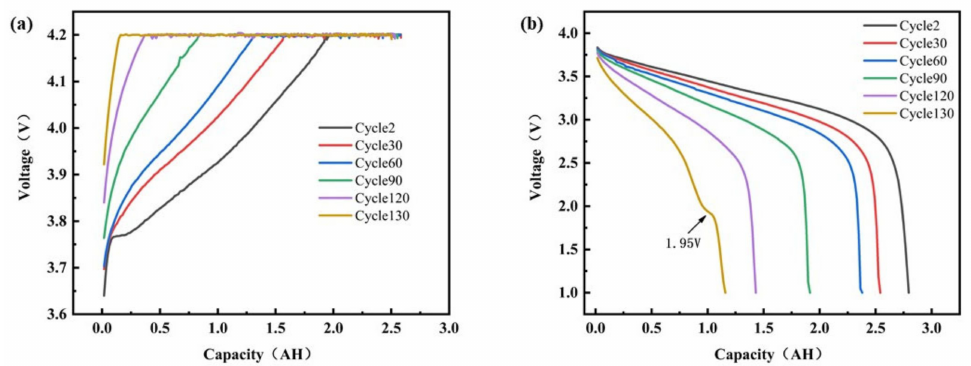
Figure 2. ( a , b ) The charge/discharge voltage and capacity curve of a -type NCM811 battery during 130 cycles at the cycle ratio of 2 C with the cut-off voltage of 1